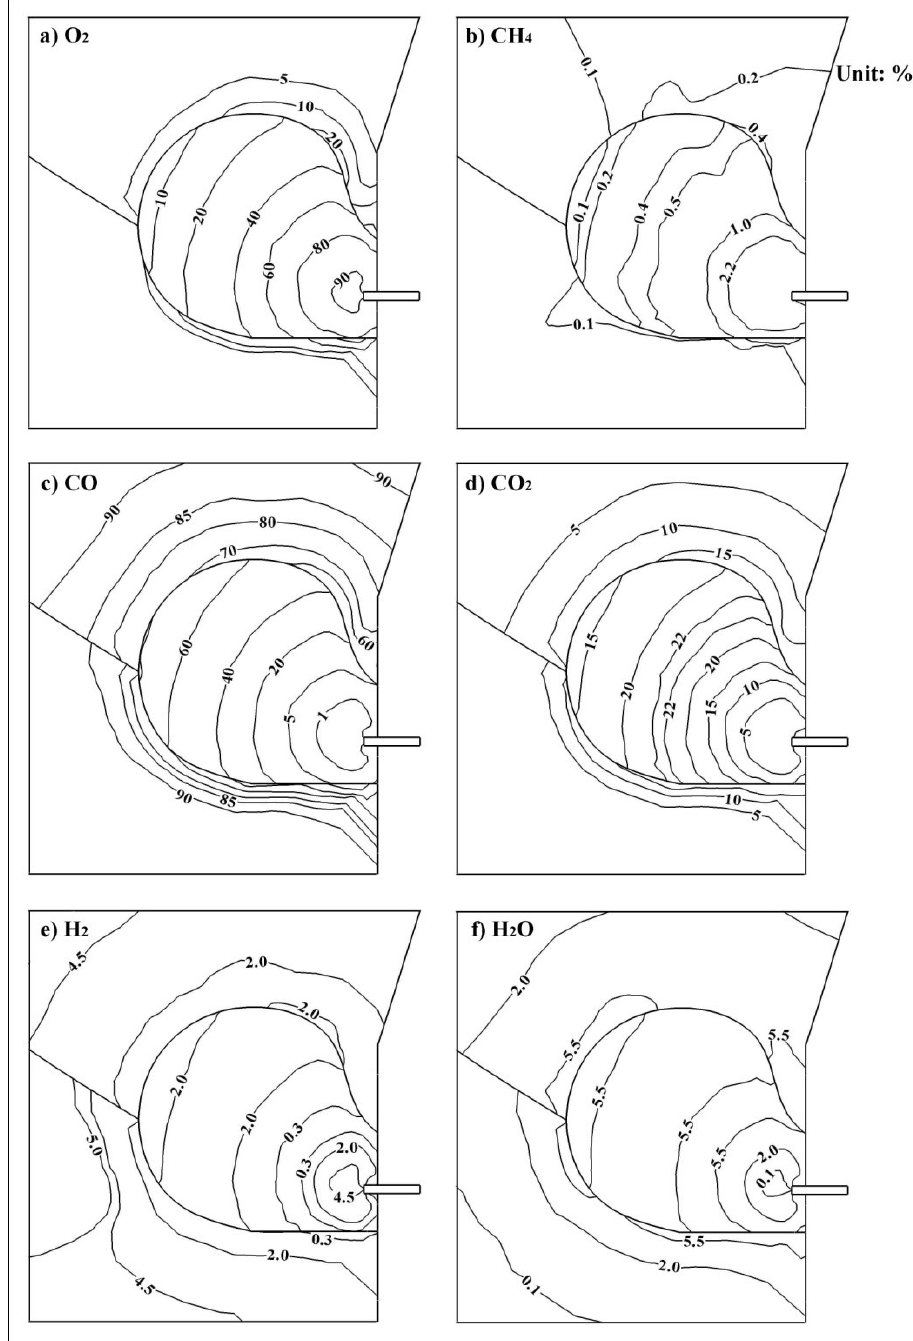
Figure 9: Volume fraction distributions of gas species around raceway for additional COG injection with a concentration of 8%